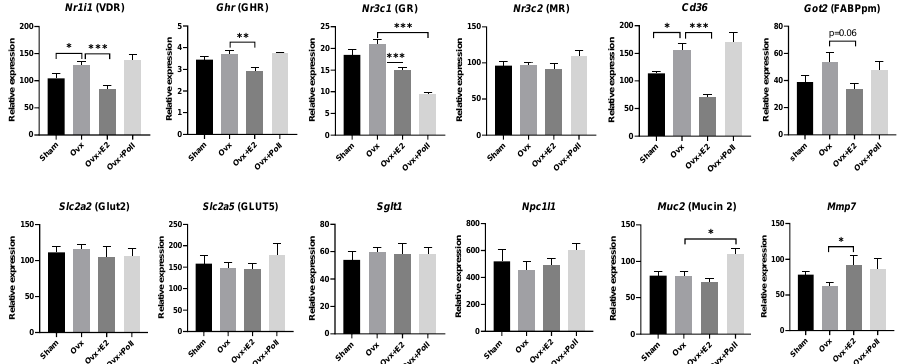
Figure 3. Effect of ovariectomy alone (Ovx) or with 17 β -estradiol (E2) supplementation (Ovx+E2) or with exposure to pollutants (Ovx + Poll) on the expression of genes encoding various nuclear receptors, lipid and glucose transporters, and mucin 2 and MMP7 in the jejunum. Values are means ± SEM with n = 6–8. *** p < 0.001; ** p < 0.01; * p < 0.05. Sham: Sham-operated mice.